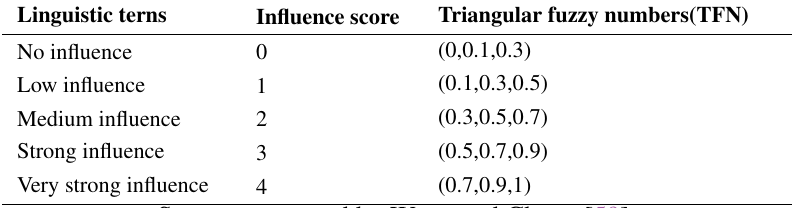
Table 2 The Fuzzy Linguistic